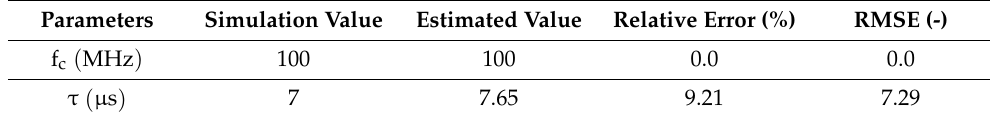
Table 3. Estimated parameters of the received BPSK signal at an SNR = − 20 dB.